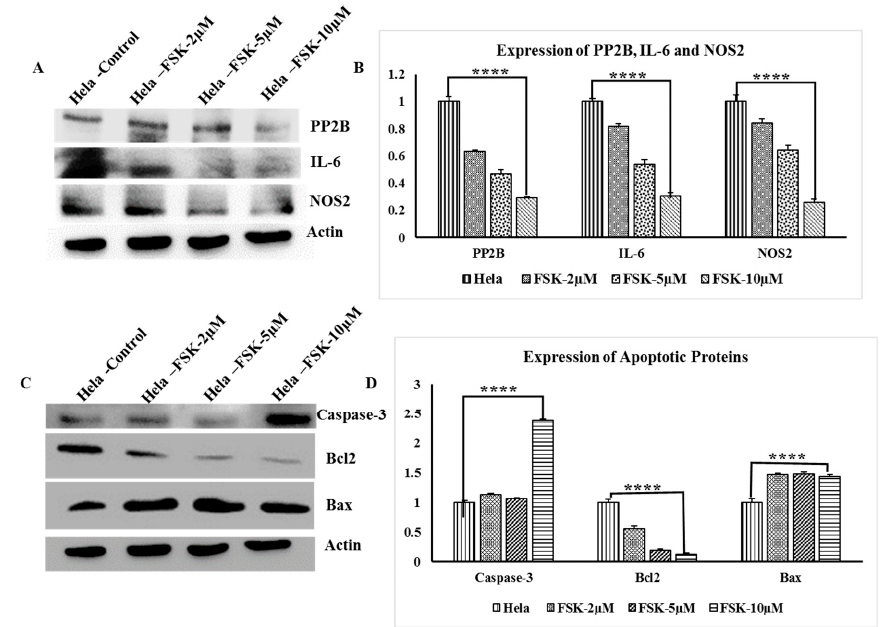
Figure 7. Western blot results: ( A ). Expression Analysis of PP2B, Interleukin-6 and iNos (NOS2) upon treatment of Forskolin Compound. Treatments in HeLa (2 µM, 5 µM, and 10 µM) Cell lysates were subjected to Western blot analysis with PP2B, IL-6, and NOS2 antibody followed by sequential re probing against Actin. ( B ) Bar graph below indicates densitometric analysis of bands in immunoblot. ( C ) Expression Analysis of Caspase-3, Bcl2 and Bax upon treatment of Forskolin Compound HeLa and Forskolin-Treatments in HeLa (2 µM, 5 µM, and 10 µM) Cell lysates were subjected to Western blot analysis with Caspase-3, Bcl2 and Bax antibody followed by sequential re probing against Actin. ( D ) Densitometric analysis of the bands in Western blot, (****denotes p < 0.0001). 3.10. Analysis Apoptotic Proteins Apoptosis protein analysis of Bcl-2, Bax, and Caspase-3 protein was determined by Western blot analysis after overnight incubation with treatment of FSK-2 µM, FSK-5 µM, and FSK-10 µM of Forskolin on HeLa cervical cancer cells. Actin was reported as internal control. It is evident that the incubation with Forskolin caused relative increase in caspase-3 at FSK-10 µM concentration. Likewise, Bax also has demonstrated a relative increase in its expression in a dose dependent as Bax is pro-apoptotic protein from Bcl-2 family. The Bcl-2 protein expression was dose-dependently down- regulated with Forskolin treatment in HeLa cancer cells, as this Bcl2 is an anti-apoptotic protein from Bcl-2 family, Figure 7B. 4. Discussion It is well documented that over expression of oestrogen leads to several pathological diseases including cervical cancer in women [4]. Predominantly, the oestrogen is generated due to the enzymatic action of aromatase on androgens. Furthermore, it is reported that oestrogen plays a pivotal role in HPV persistence and subsequent neoplastic progression by elevating the viral gene expression [4]. Logically, inhibiting the formation of oestrogen leads to diminished levels of oestrogen thereby mitigating the disease. Accordingly, we attempted to identify a natural compound that represents the pharmacophore features of the aromatase substrate and the drug. Consequently, the Forskolin was redeemed representing the inhibitory features of the cocrystal.